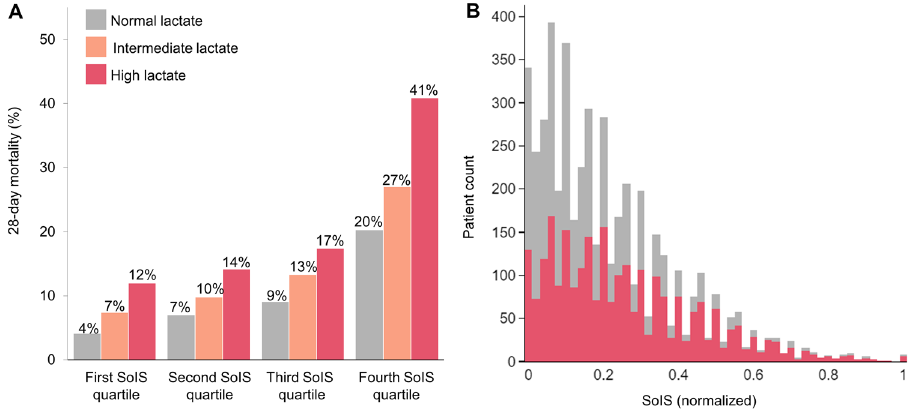
Figure 2. ( A ) 28-day mortality rates by severity of illness score (SoIS) and lactate level. Both higher SoIS and higher serum lactate levels are consistently associated with higher 28-day mortality rates. ( B ) Distribution of SoIS in the normal (gray) and high serum lactate (red) group. Patients with normal serum lactate tend to have lower SoIS. SoIS are normalized to allow comparison across the cohorts.